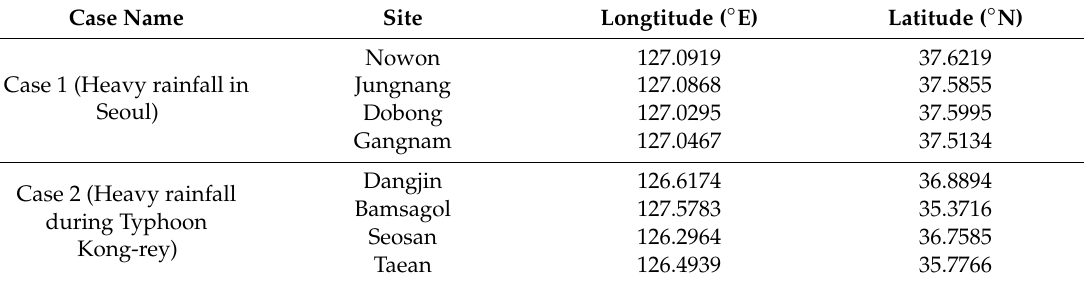
Table 1. Location information of observational sites used for the verification of